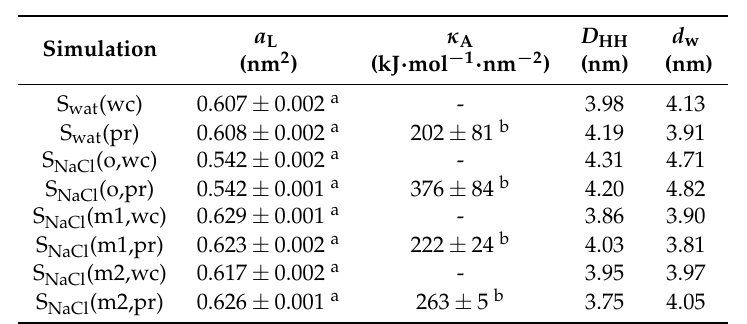
Table 1. Area per lipid a L (Equation (9)), area compressibility κ A (Equation (17)), bilayer thickness D HH (Section 4.3.1) and water layer thickness d w (Equation (10)) for systems containing membrane patches of 64 lipids per leaflet. The simulation acronyms are explained in Table 7. The area compressibility is only reported for simulations involving the Parrinello–Rahman